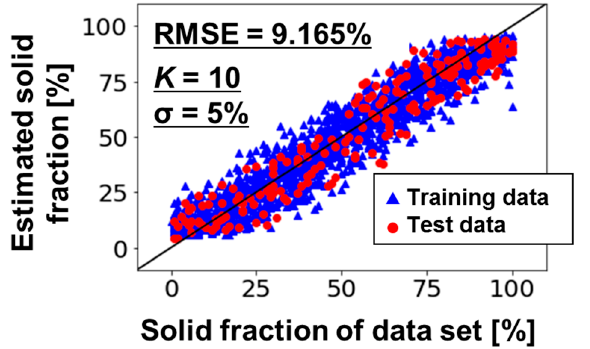
Figure 6. Results of solid–liquid phase fraction analysis by KNN for the simulated spectral dataset with random errors ( σ = 5%) for both the training and testing data.